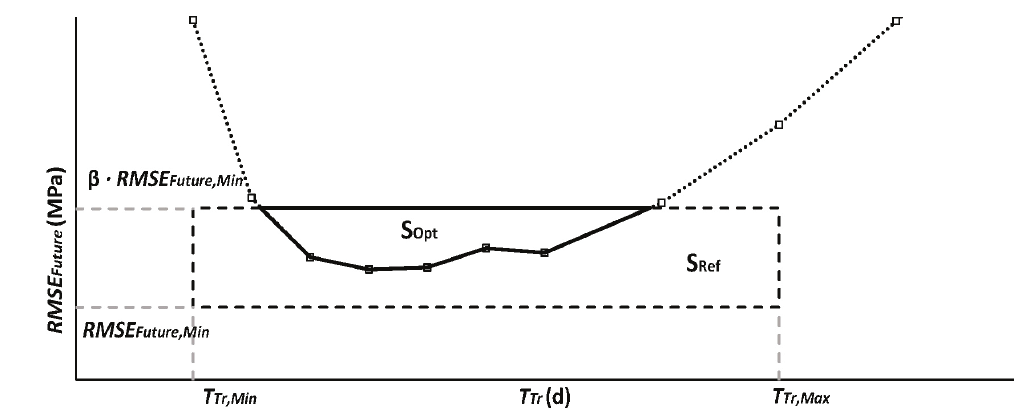
Fig. 12 – Optimum and reference surfaces of RMSE